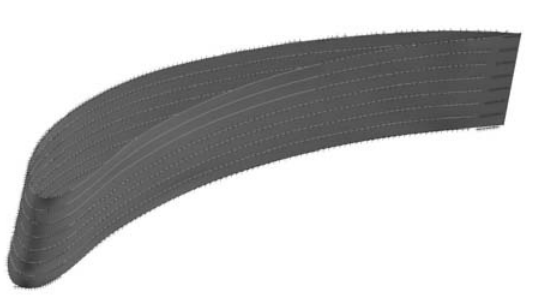
Fig 3. Photogrammetrically obtained sliced point cloud with best fit splines and surface created